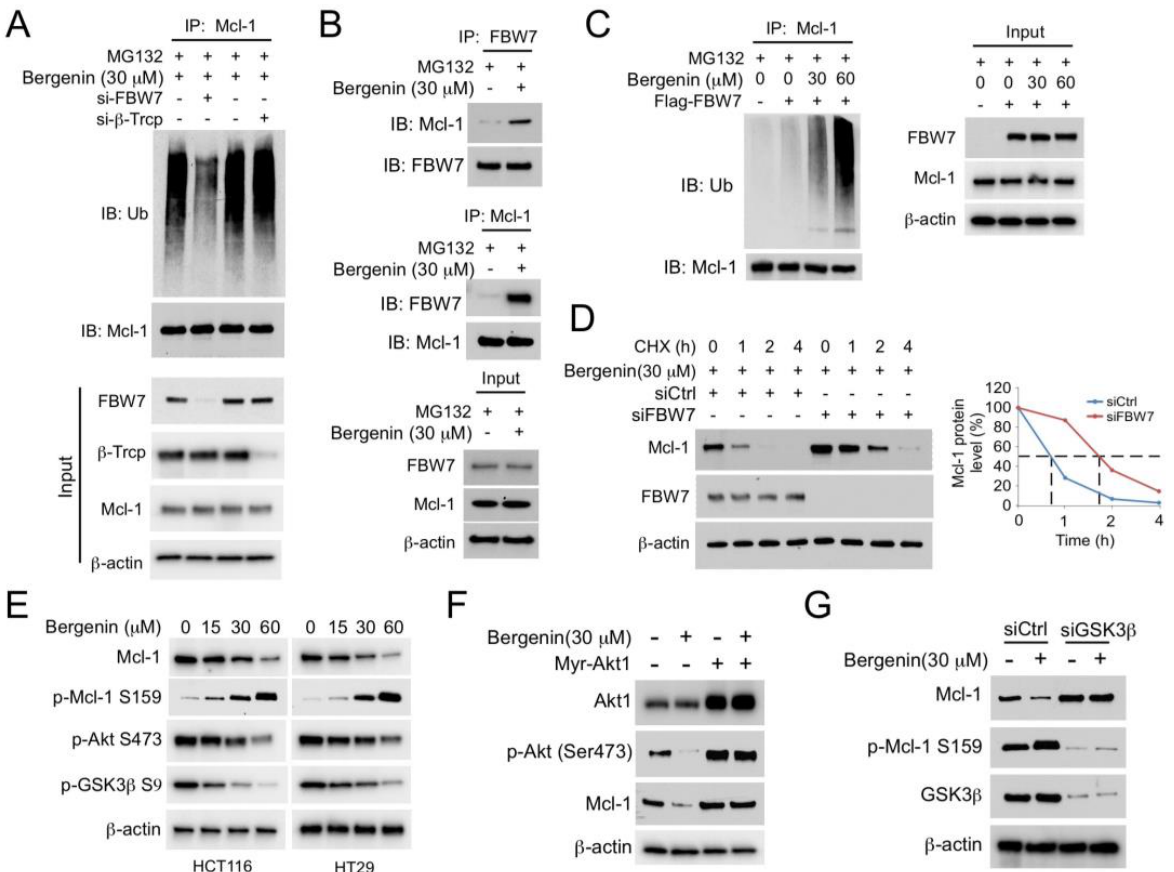
Figure 3. FBW7 is required for bergenin − induced Mcl − 1 degradation. ( A ) HCT116 cells were transfected with siFBW7 or si β − TRCP for 24 h, incubated with bergenin for 48 h, and treated with MG132